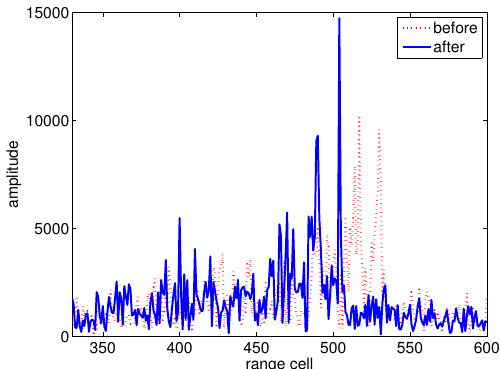
Figure 8. HRRP of the aircraft before and after speed compensation.